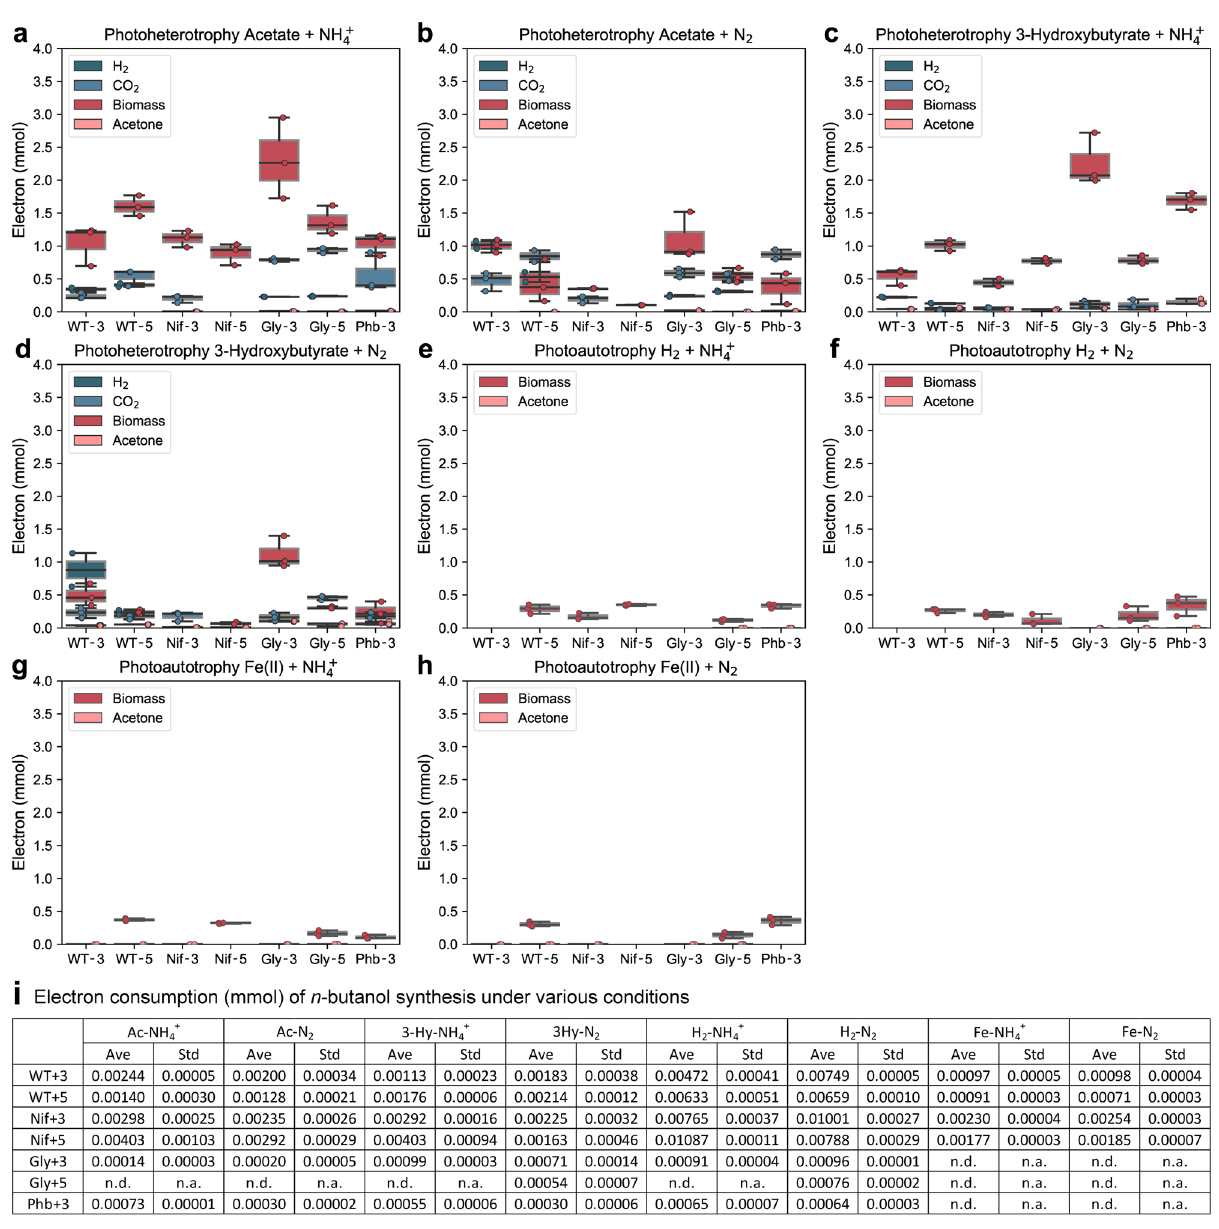
Fig. 7 Using Hydrogen as an electron donor resulted in low electron fl ow in byproduct generation. Electron consumption of n -butanol/acetone/H 2 / CO 2 /biomass synthesis under various incubation conditions. a acetate + NH 4 + (photoheterotrophy) b acetate + N 2 (photoheterotrophy) c 3- hydroxybutyrate + NH 4 + (photoheterotrophy) d 3-hydroxybutyrate + N 2 (photoheterotrophy) e hydrogen (H 2 ) + NH 4 + (photoautotrophy) f hydrogen -butanol synthesis under various incubation conditions.CO 2 was present in all conditions. Data are from n = 3 of independent experiments. WT-3: